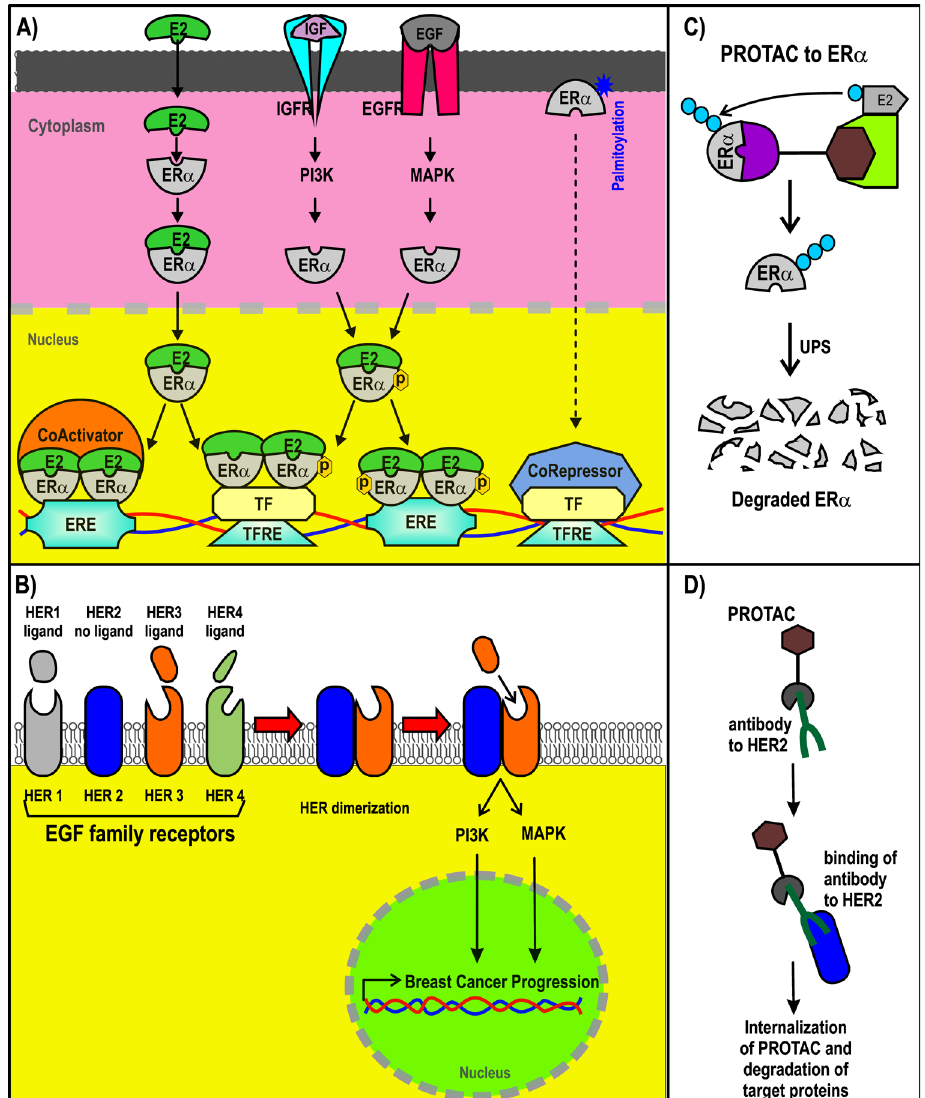
Figure 2. ER+ and HER2+ BC and PROTACs. A) Signaling pathways triggered by ER; B) representation of PROTACs designed for ER; C) signaling pathways of HER2+; D) design of antibody (Ab)-PROTAC conjugated using an Ab for HER2. ERE: estrogen response element; IGFR: IGF receptor; PI3K: phosphatidylinositol-4,5-bisphosphate 3-kinase; EGFR: EGF receptor; MAPK: mitogen-activated protein kinase; TF: transcription factor; TFRE: TF response elements; ER+: